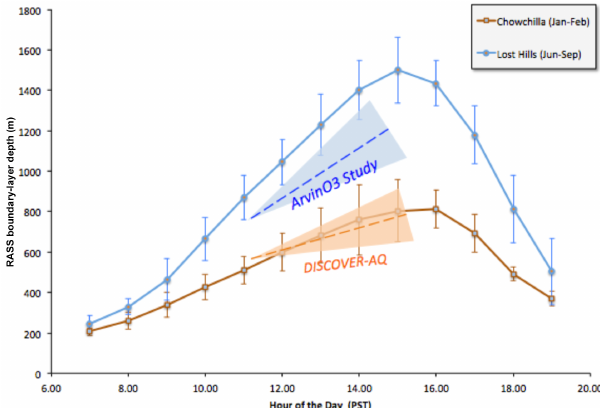
Figure 4. Diurnal boundary-layer development as observed dur- ing the two experiments presented here, and the average data from the corresponding months and locations presented in Bianco et al. (2011) as the solid line. The dotted lines are the average ABL growth rates from this study, for each respective mission, and the larger area represents the spread.